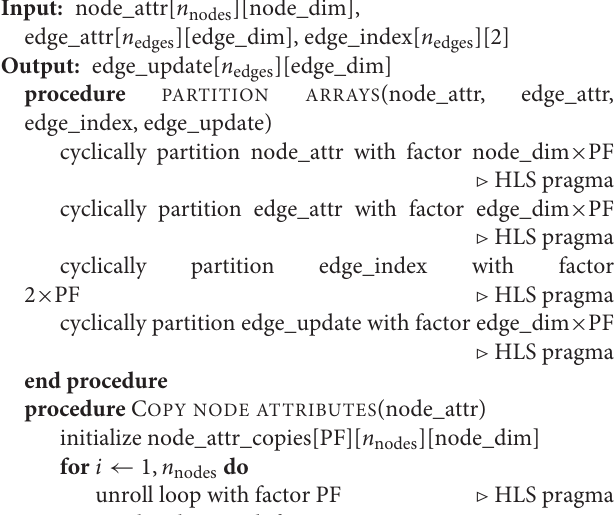
Algorithm 2 : Resource-optimized edge